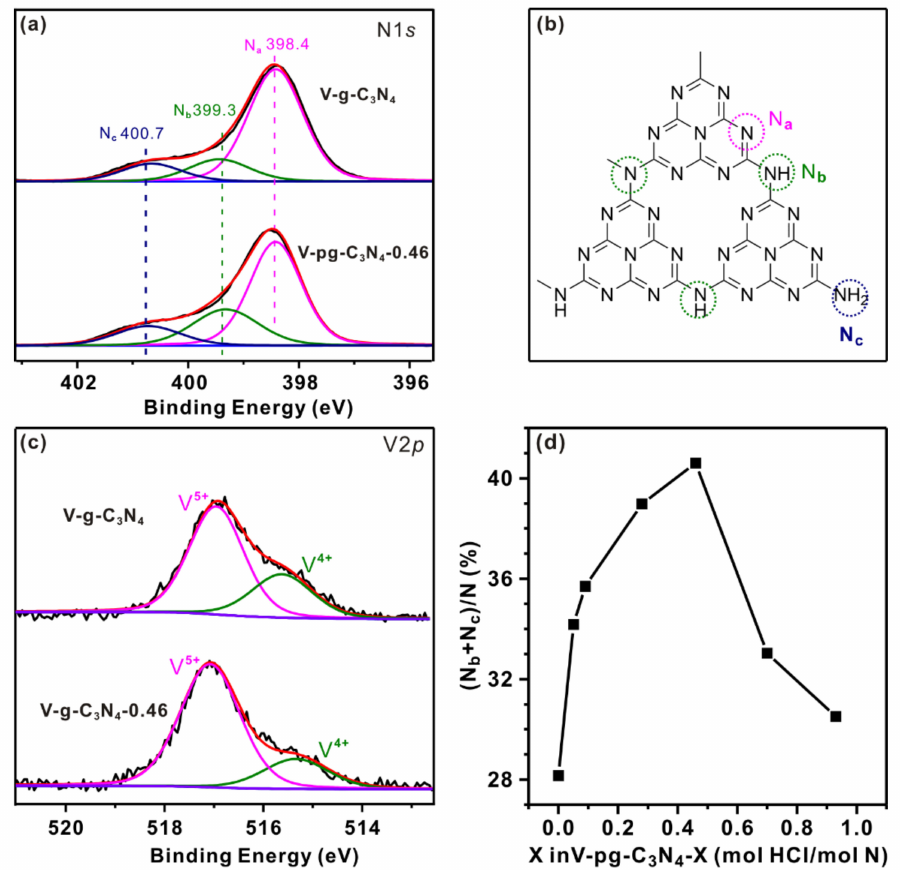
Figure 2. XPS analysis of V-g-C 3 N 4 and V-pg-C 3 N 4 -0.46 samples. ( a ) N1 s ; ( b ) a possible structure of g-C 3 N 4 reproduced with permission from [21]. Copyright 2018, Elsevier; ( c ) V2 p ; ( d ) the percentage of (N b + Nc) as a function of X in V-pg-C 3 N 4